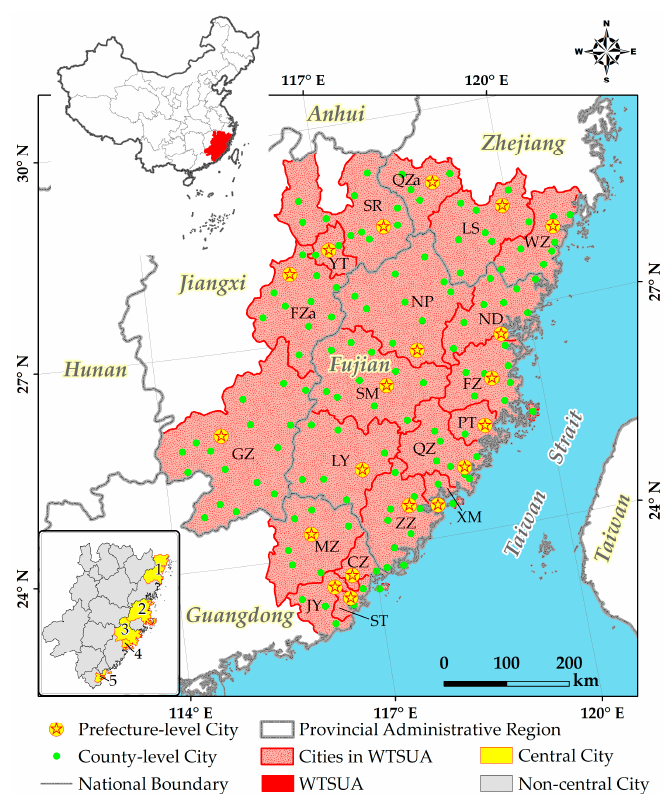
Figure 1. Location of the study area (WTSUA represents the West Taiwan Strait Urban Agglomeration; QZa: Quzhou city, LS: Lishui city, WZ: Wenzhou city, ND: Ningde city, NP: